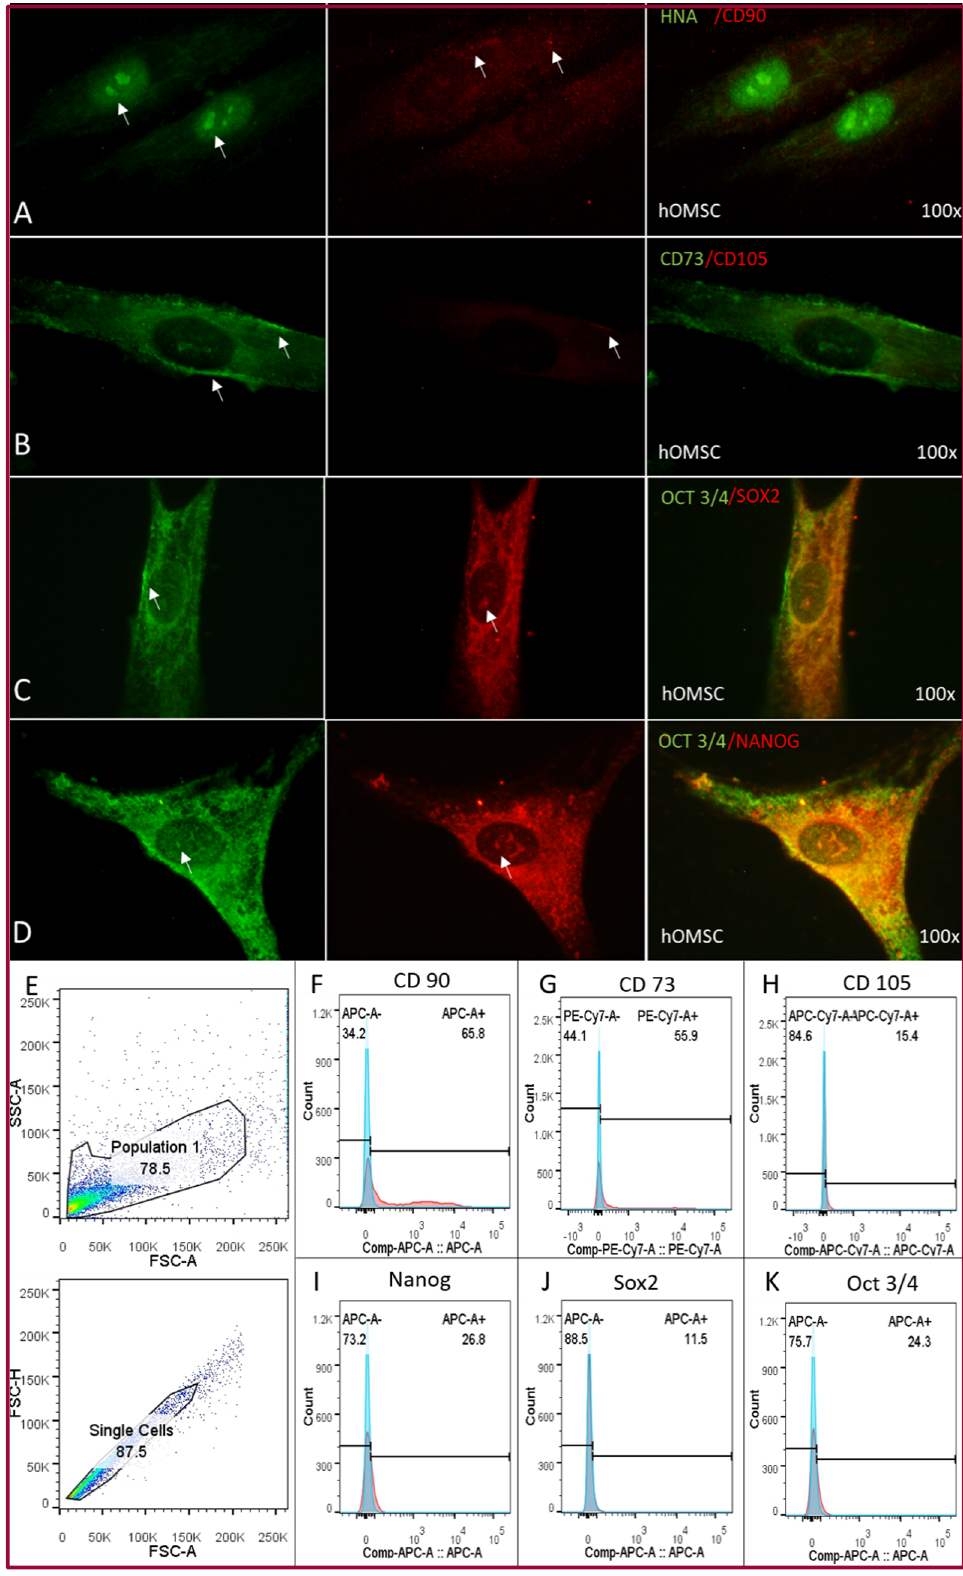
Figure 4. hOMSC characterization. ( A – D ) Immunofluorescence of hOMSCs and pluripotency markers. White arrows mark areas of positivity. ( E ) Flow cytometry gates. Percentage of positive cells in culture for hOMSCs—( F ) CD90 65.8%, ( G) CD73 55.9%, ( H ) CD105 15.4% and pluripotency markers—( I ) Nanog 26.8%, ( J ) Sox2 11.5% and ( K ) Oct3/4, 24.3%.